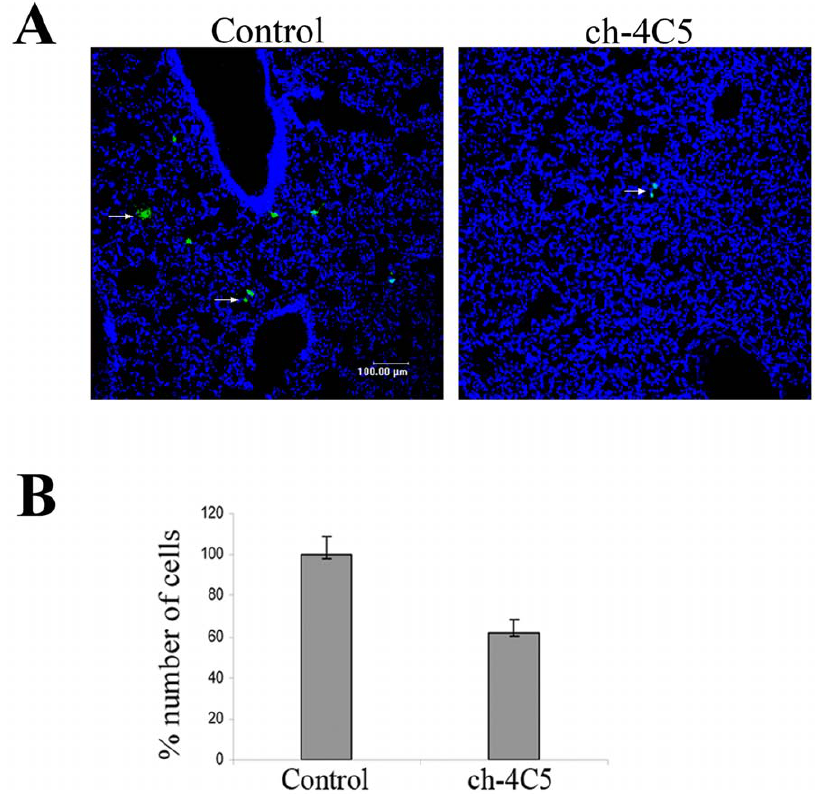
Figure 6. ch-4C5 inhibits the metastatic deposition of MDA-MB-453 cancer cells into the lungs of SCID mice. Control or ch-4C5 treated MDA-MB-453 cells were labeled with the fluorescent dye DiO and injected into SCID mice as described in Materials and Methods. Evaluation of metastatic deposits was performed several hours later. A. Representative cryosections of the lungs of control and ch-4C5 treated mice. The arrows show MDA-MB-453 cells stained with DiO present in the lung tissue. A significant decrease in the deposition of cancer cells was observed in the lungs of ch-4C5 treated mice. Scale bar: 100 m m B . Quantitative effect of ch-4C5 on the metastatic deposition of MDA-MB-453 cells into the lungs, showed a 38% inhibition when compared to control animals. The bars represent the average of two independent experiments 6 SEM. Statistical significance of differences was tested by Student’s t test (p , 0.01).